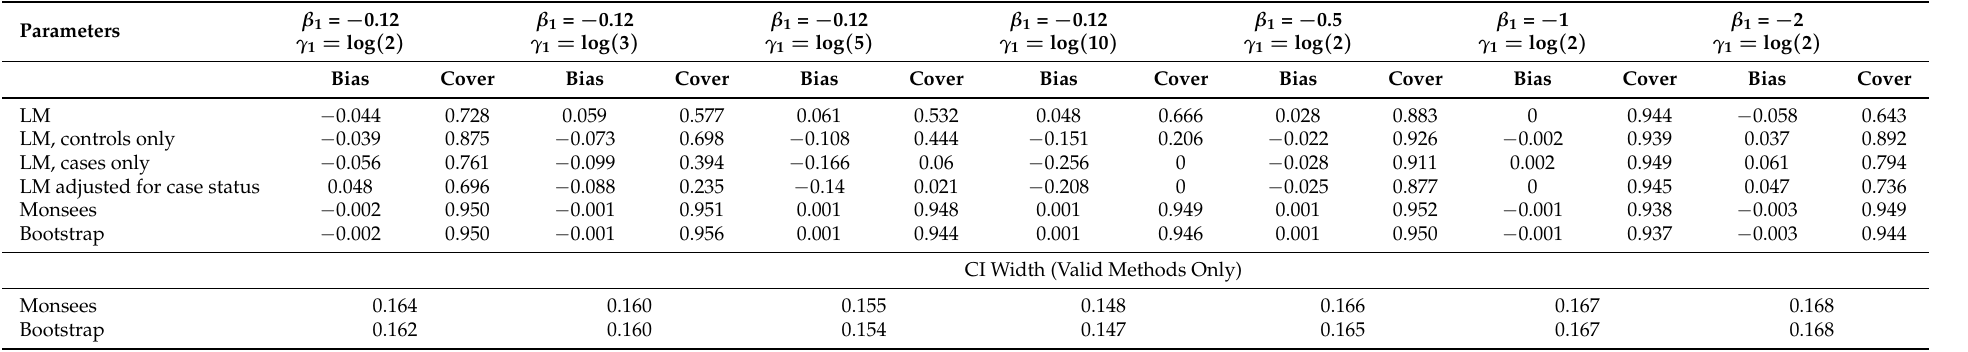
Table 1. Results of simulations for intermediate continuous